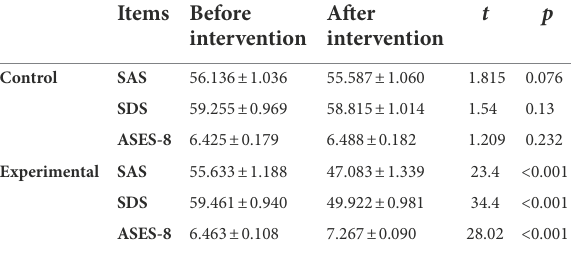
TABLE 3 Within-group comparison of SAS, SDS, and ASES-8 scores before and after nursing intervention (points, − x ± s ). Items Before After intervention Between-group comparison of patient satisfaction with nursing care Patient satisfaction with nursing care of the experimental group (96%) was better than that (92%) of the control group. However, there was no statistically significant difference between them ( p > 0.05; Table 4).